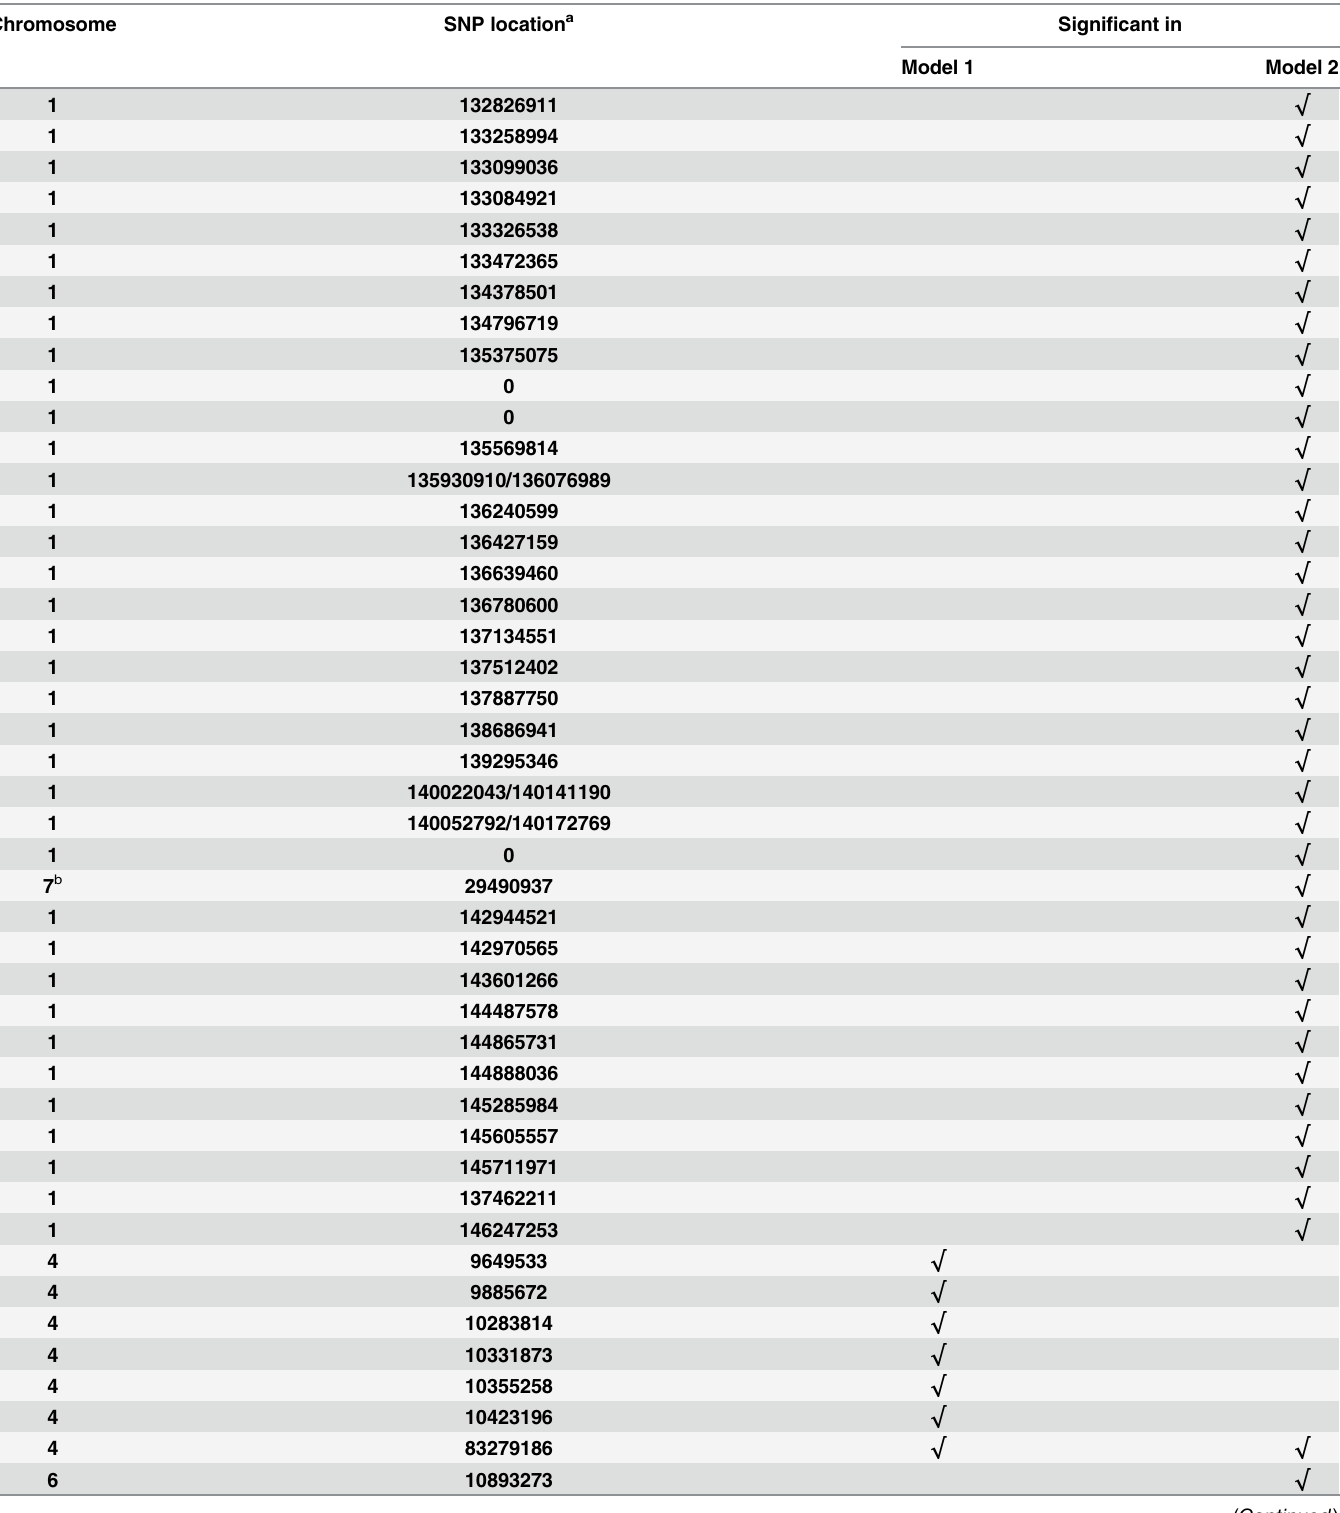
Table 2. SNP loci at which mismatches between donor and recipient are significantly associated with rejection (57 SNPs) or acceptance (4 SNPs) of a corneal